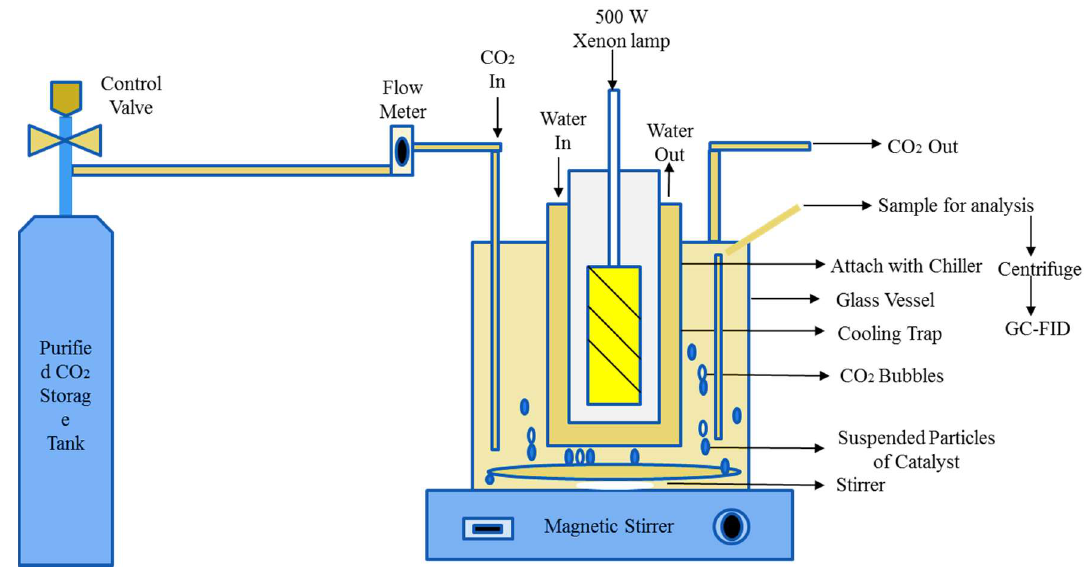
Figure 10. Schematic diagram of the reactor setup.